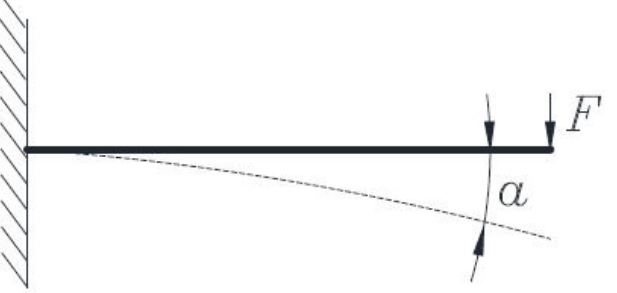
Figure 2. Schematic diagram of leaf spring force analysis.